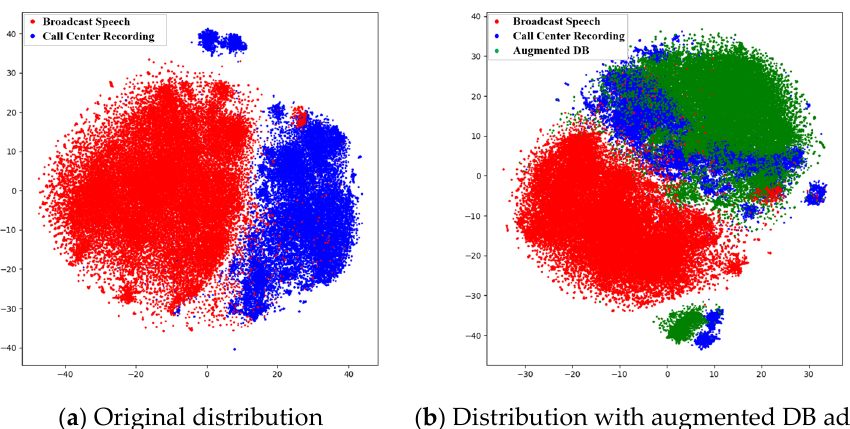
Figure 8. Spatial distribution of sequence-level attributes in the acoustic space of the call center recordings, broadcast speech, and augmented DB.